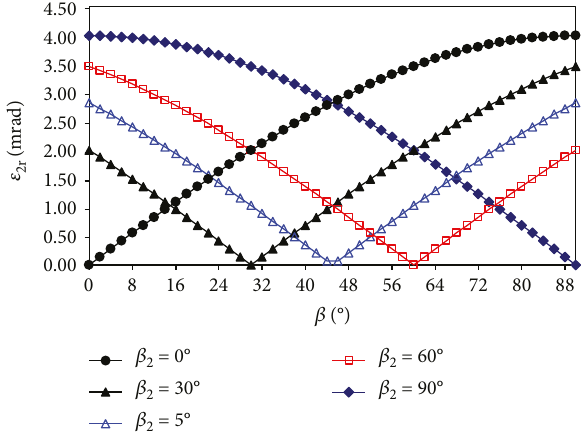
Figure 13: Error transmission law of the tracking error of the spin axis transmission to dish concentrator (spin axis tracking error is 4.0